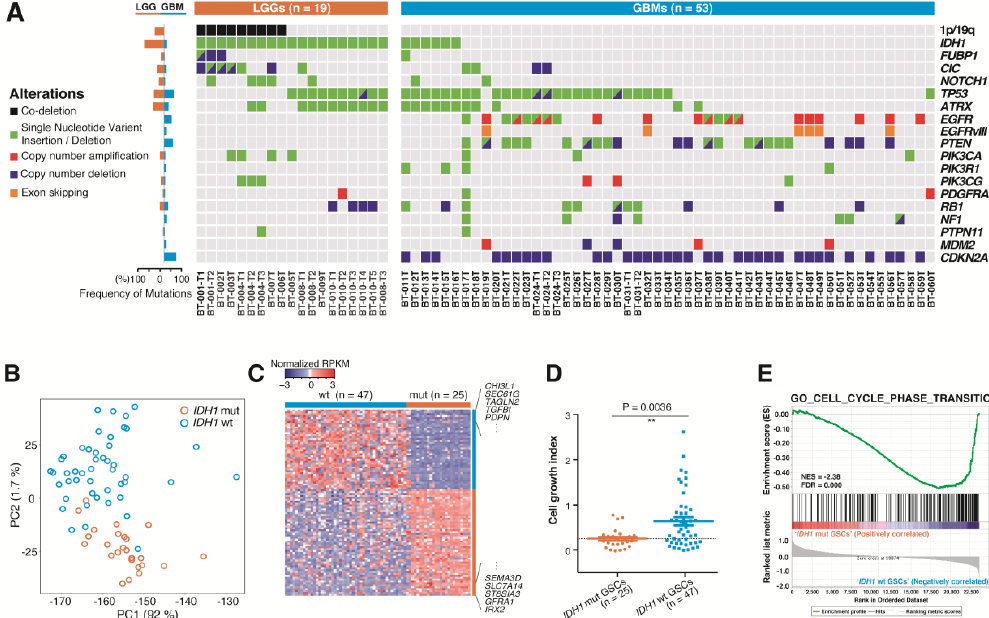
Figure 2. Genomic landscape of 72 di ff usely infiltrating gliomas (DIGs) and distinct genomic characteristics between IDH1 -mutated (mut) and wild-type (wt) glioma stem cells (GSCs). ( A ) The alterations in the frequently mutated genes in DIGs for 19 lower-grade gliomas (LGGs) and 53 glioblastomas. On the left, the alteration frequency of each gene was compared between LGGs and glioblastomas. ( B ) The principle component analysis (PCA) of the gene expression profiles of 72 DIGs ( IDH1 -wt (n = 47) and IDH- mut DIGs (n = 25), using newly curated tumor-intrinsic genes (refer to Materials and Methods). The blue and orange dots indicate IDH1 -wt and IDH1 -mut GSCs, respectively. ( C ) Differentially expressed genes between GFSCAN IDH1 -wt and -mut GSCs ( p value ≤ 0.05 and Benjamini q value ≤ 0.1). ( D ) The cell growth index of IDH1 -mut and -wt GSCs in neural basal medium supplemented with EGF and bFGF (NBE) ( p = 0.0027). ( E ) The gene-set enrichment analysis (GSEA) plot of a cell cycle-associated pathway (GO_CELL_CYCLE_PHASE_TRANSITION) between IDH1 -mut and -wt GSCs.